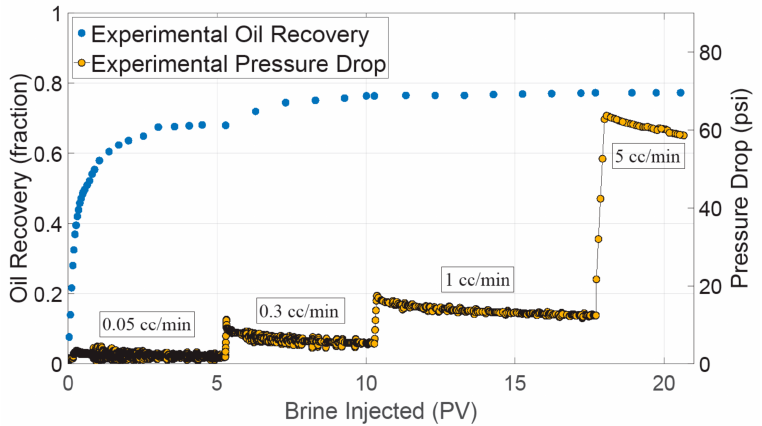
Figure 3. Oil recovery and pressure drop for